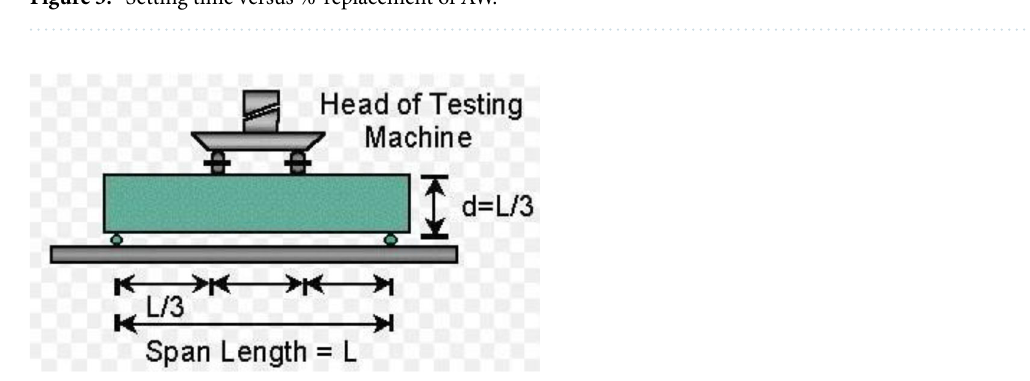
Figure 5. Setting time versus %-replacement of AW.